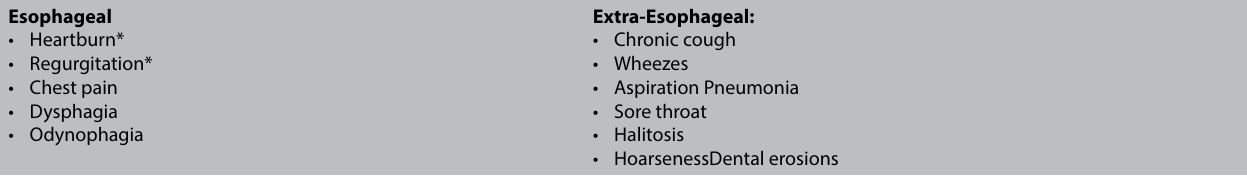
Table 2: Signs/Symptoms and complications of GERD 9,19-20,31